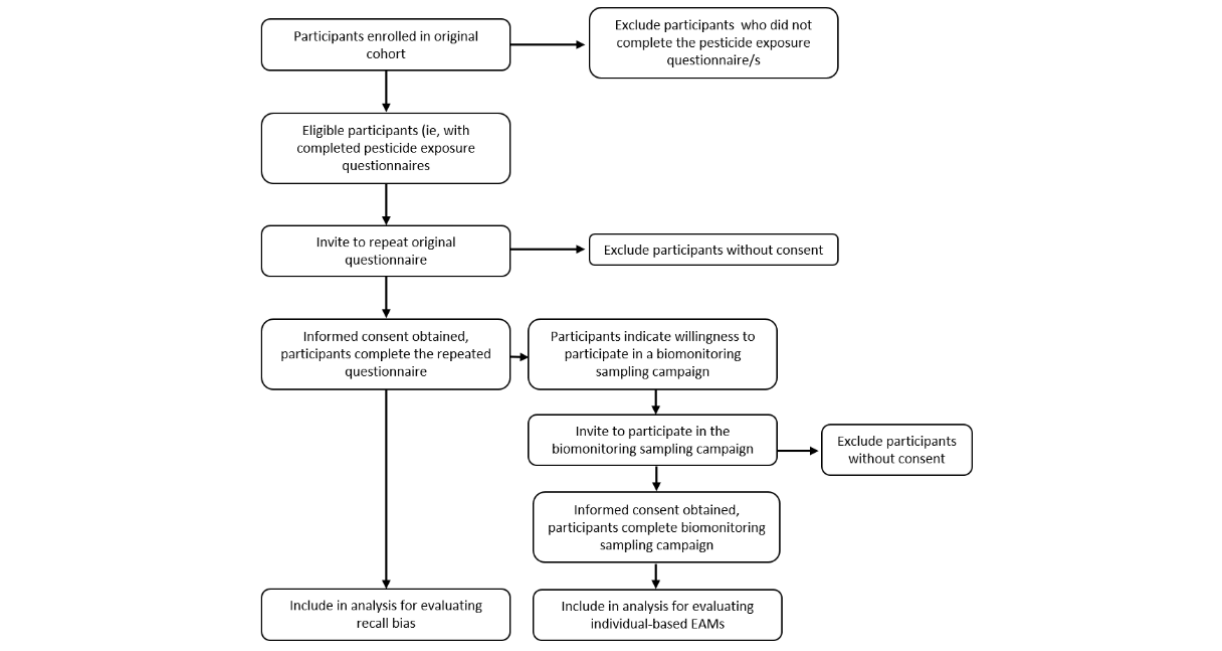
Figure 1. Summary of enrollment and data collection process. EAM: exposure assessment